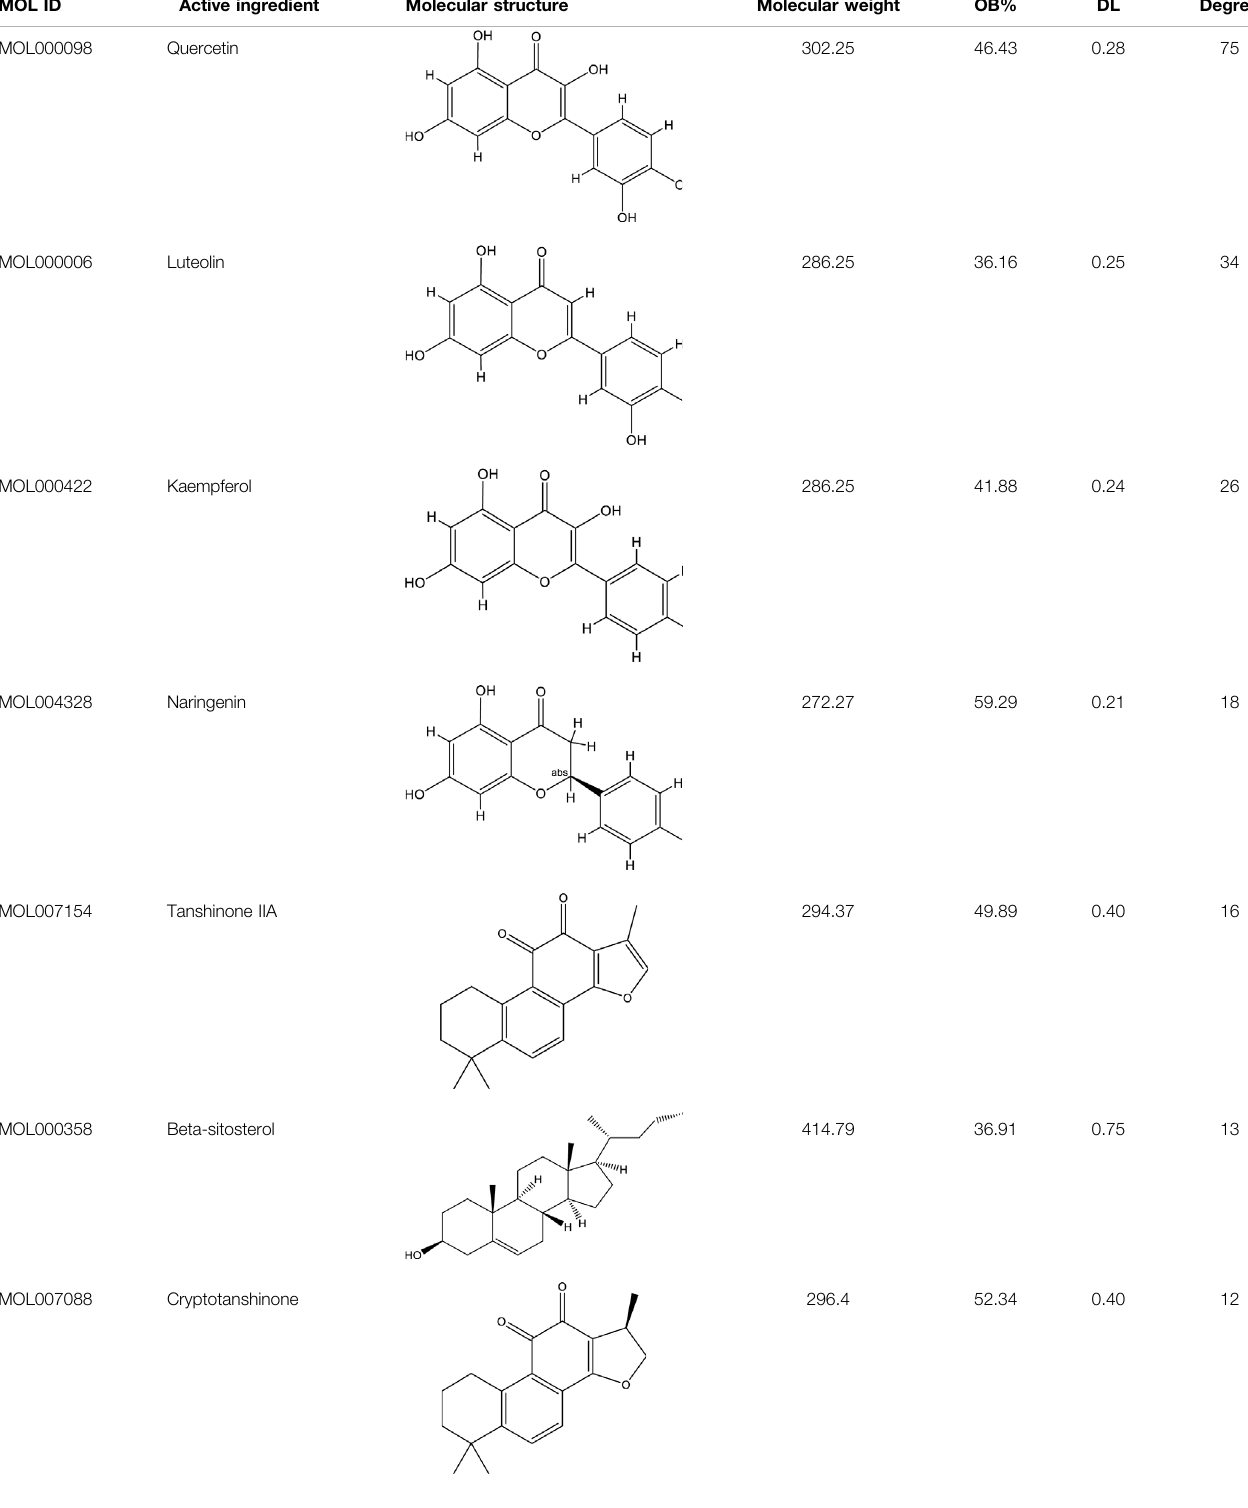
TABLE 2 | Information of the top 10 active compounds for QF in the treatment of RSV